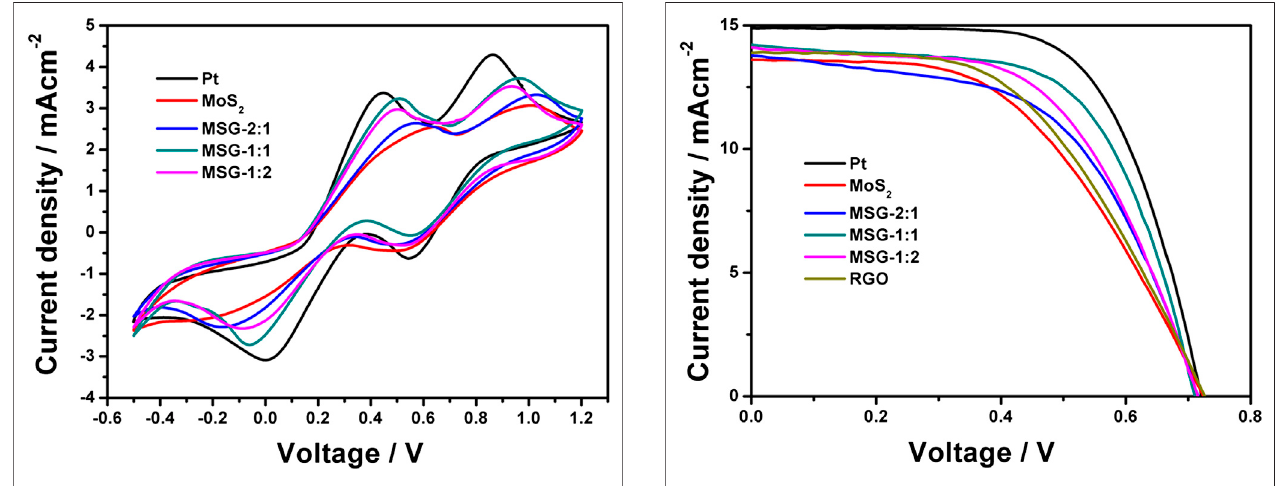
FIGURE 6 | J – V curves of DSSCs with MSG-2:1, MSG-1:1, MSG-1:2, RGO, MoS 2 , and Pt counter electrodes.